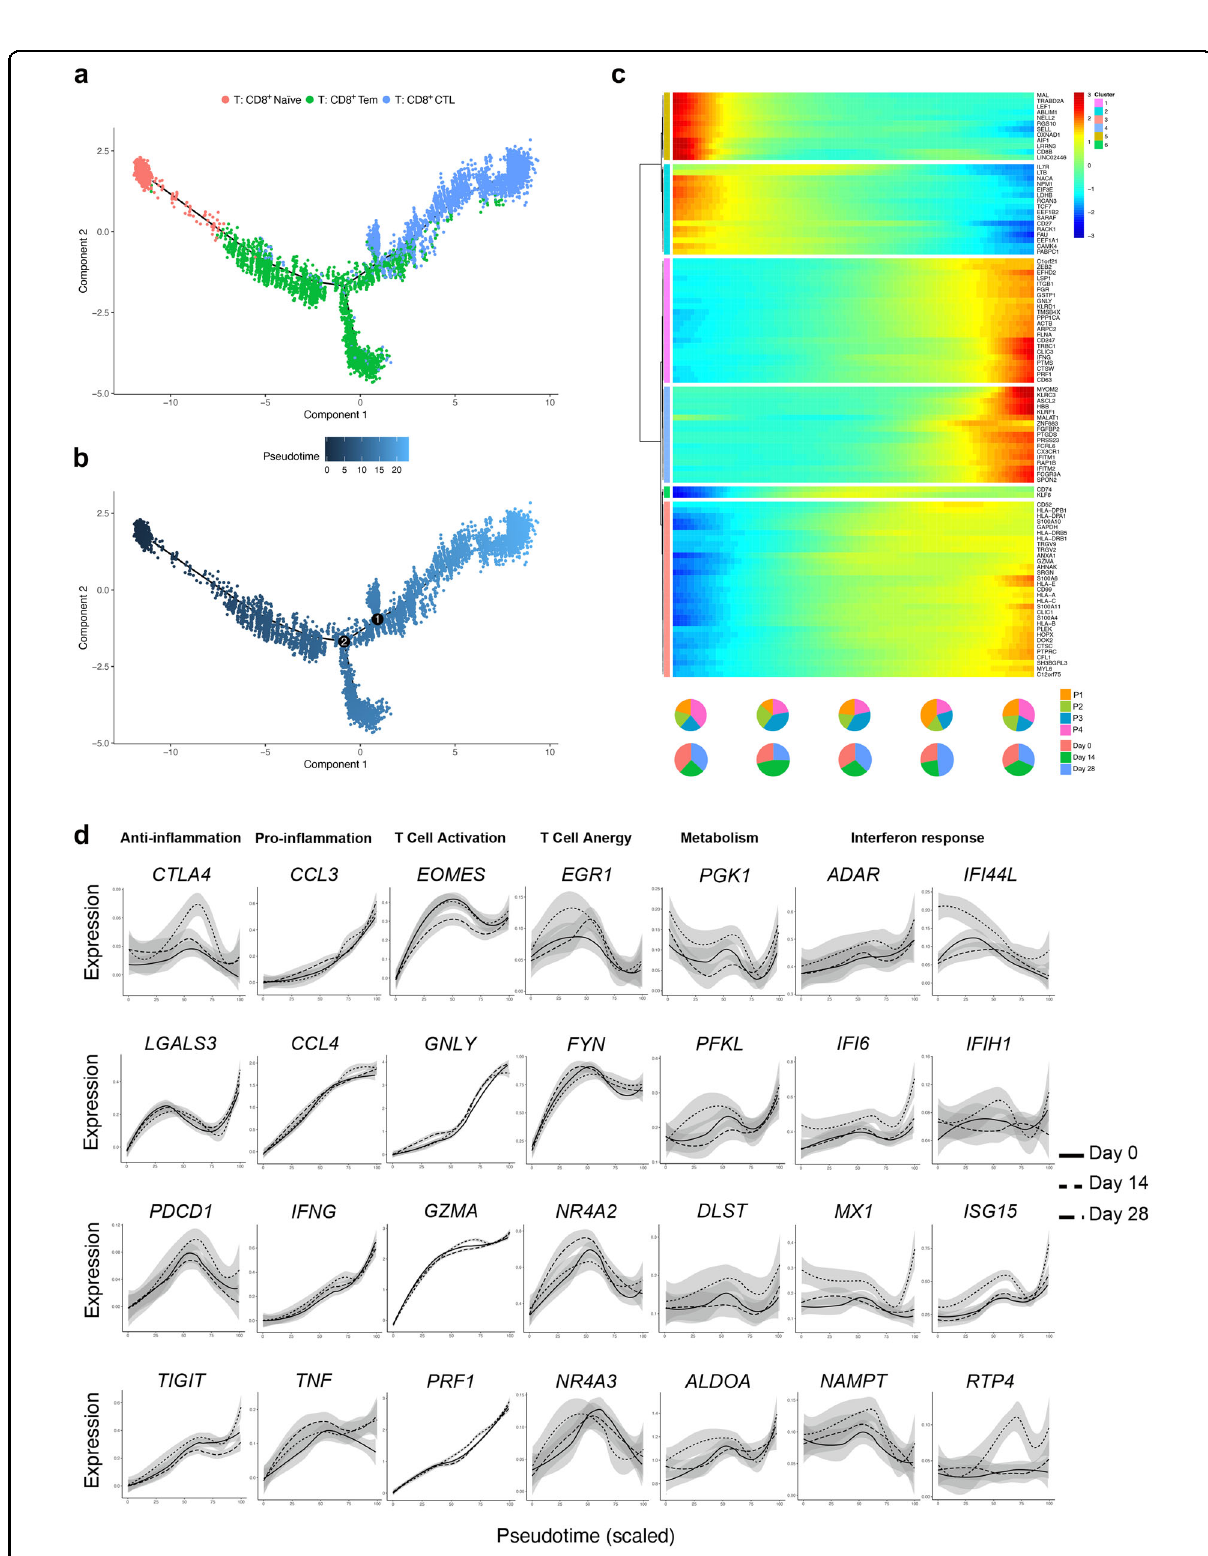
Fig. 6 Trajectory analysis revealed the overtime shifting of T cell phenotypes. a Pseudotime trajectories for CD8 + T cells based on Monocle2, color-coded for the CD8 + T cell phenotypes. b Pseudotime trajectories for CD8 + T cells, color-coded for the pseudotime. c Gene expression dynamics along the CD8 + T cells lineage. Genes were clustered into 6 gene sets, and each of them was characterized by speci fi c expression pro fi les. d Genes involved in the function and response of T cells modeled along the CD8 + T cell lineages at different timepoints. See also “ Materials and methods ” for constructing single-cell